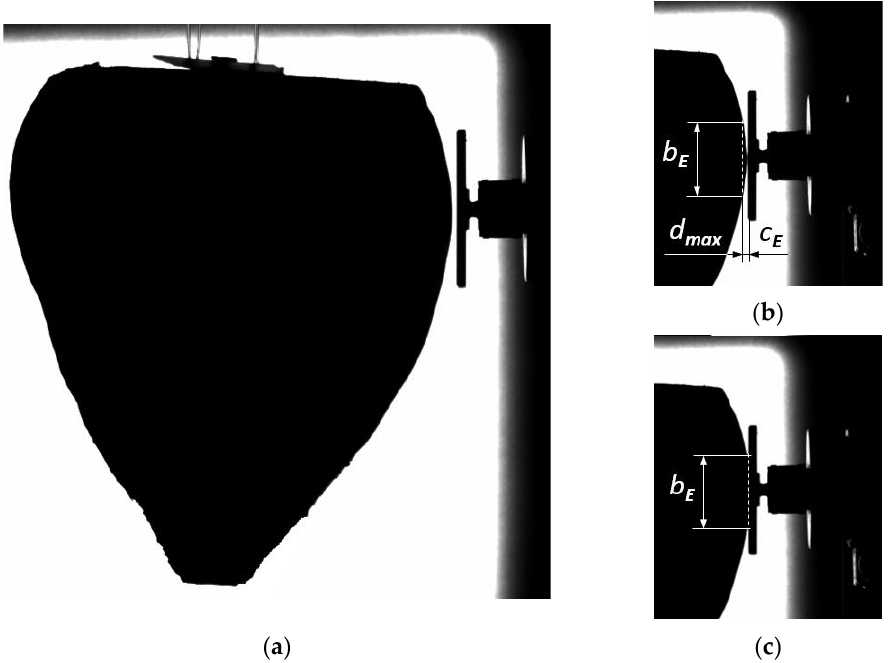
Figure 3. Image sequences of the root using the camera Phantom Miro M320 during the impact test. ( a ) The beet and resistance plate fixed to the force sensor; ( b ) the impact start; ( c ) the impact end; d max — the pictorial determination of maximal deformation d max = c E .